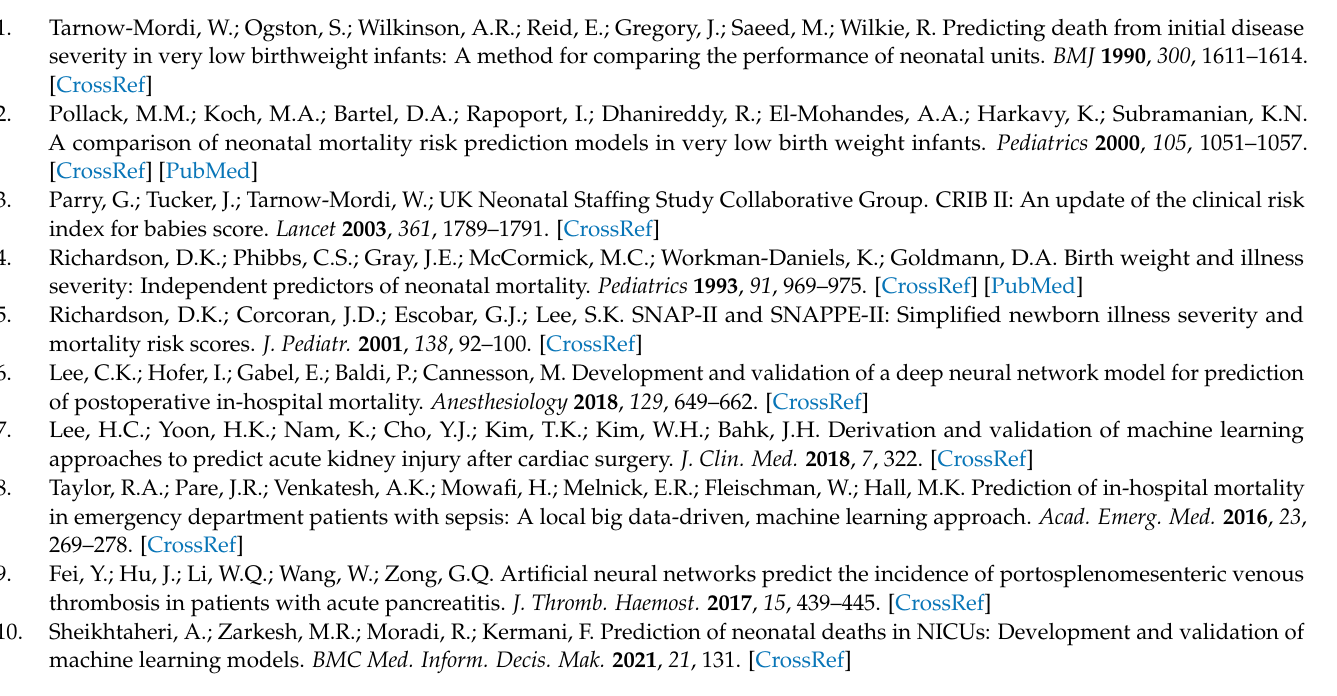
Table S1A: Maternal social history of the living and dead groups, Table S1B: Paternal social history of the living and dead groups. Table S2: Comparison of variables between KNN registry and this